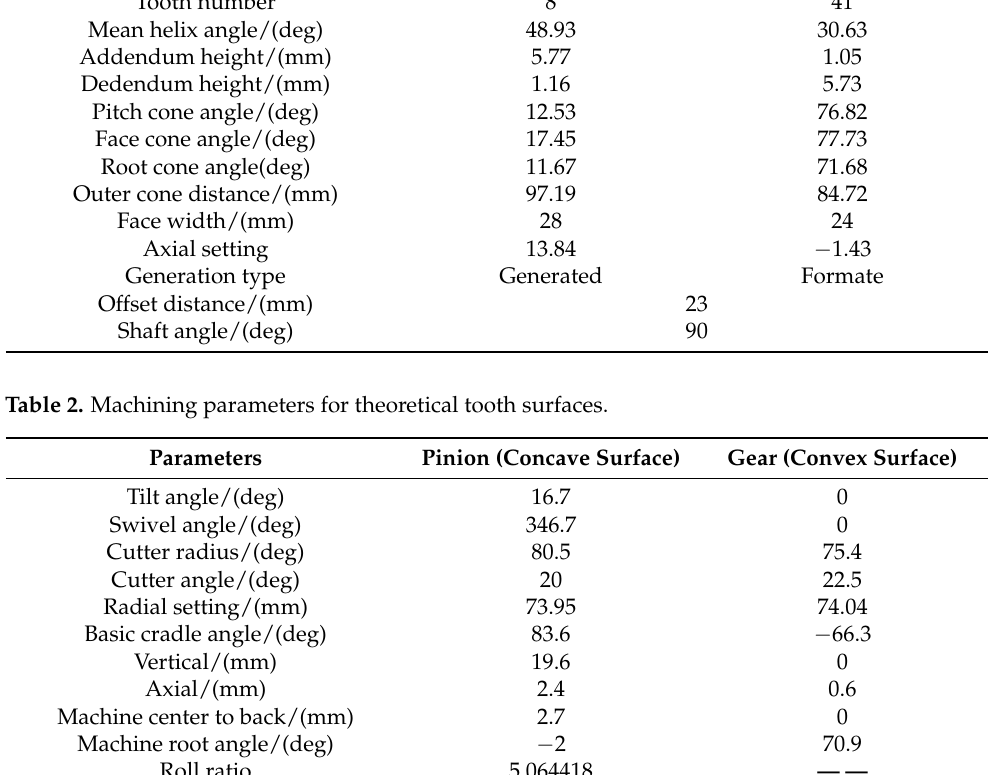
Table 1. Geometric parameters of the hypoid gear pair.